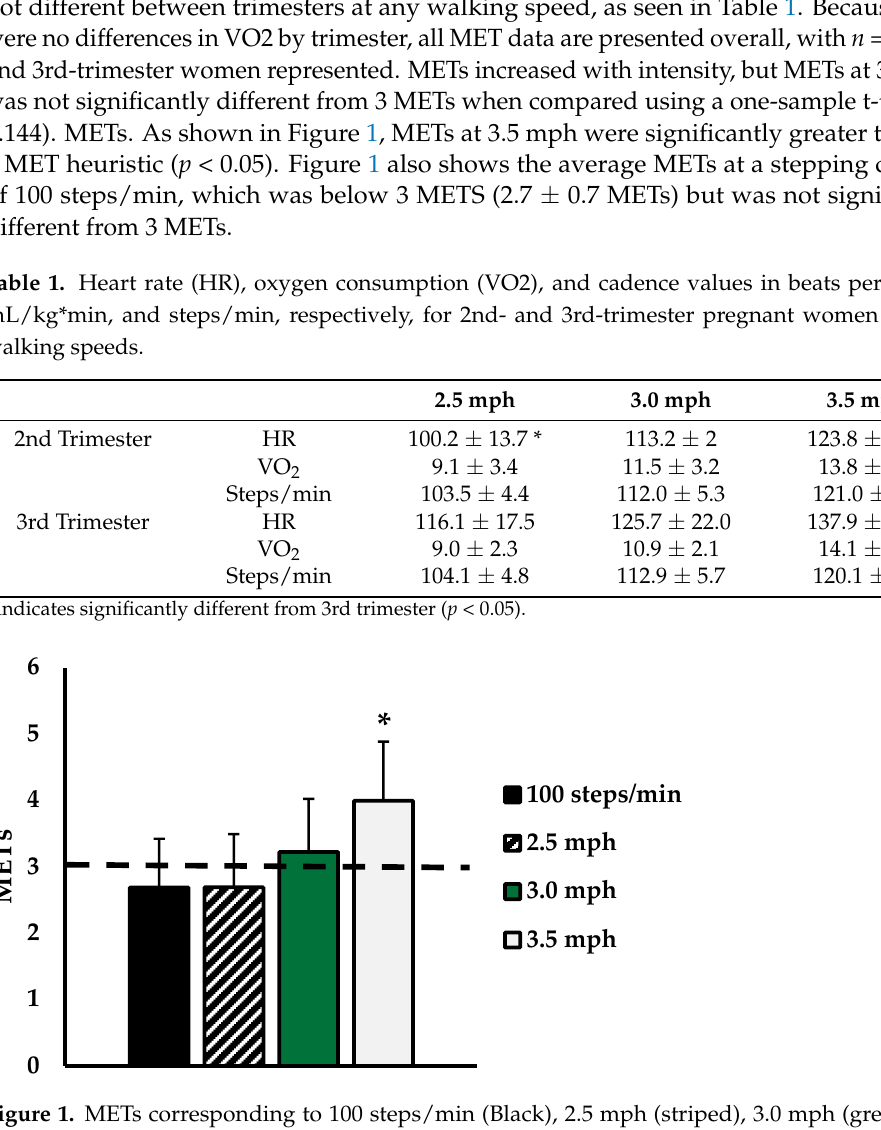
Figure 1. METs corresponding to 100 steps/min (Black), 2.5 mph (striped), 3.0 mph (green), and 3.5 mph (grey). Dashed line indicates 3 METs threshold for moderate-intensity exercise. Data are presented as mean ± SD. * indicates significantly different from 3 METs ( p < 0.05).